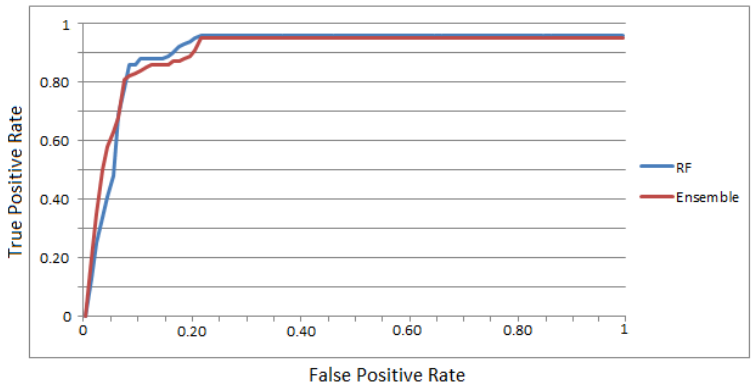
Figure 11. ROC curve of random forest and the proposed ensemble method.